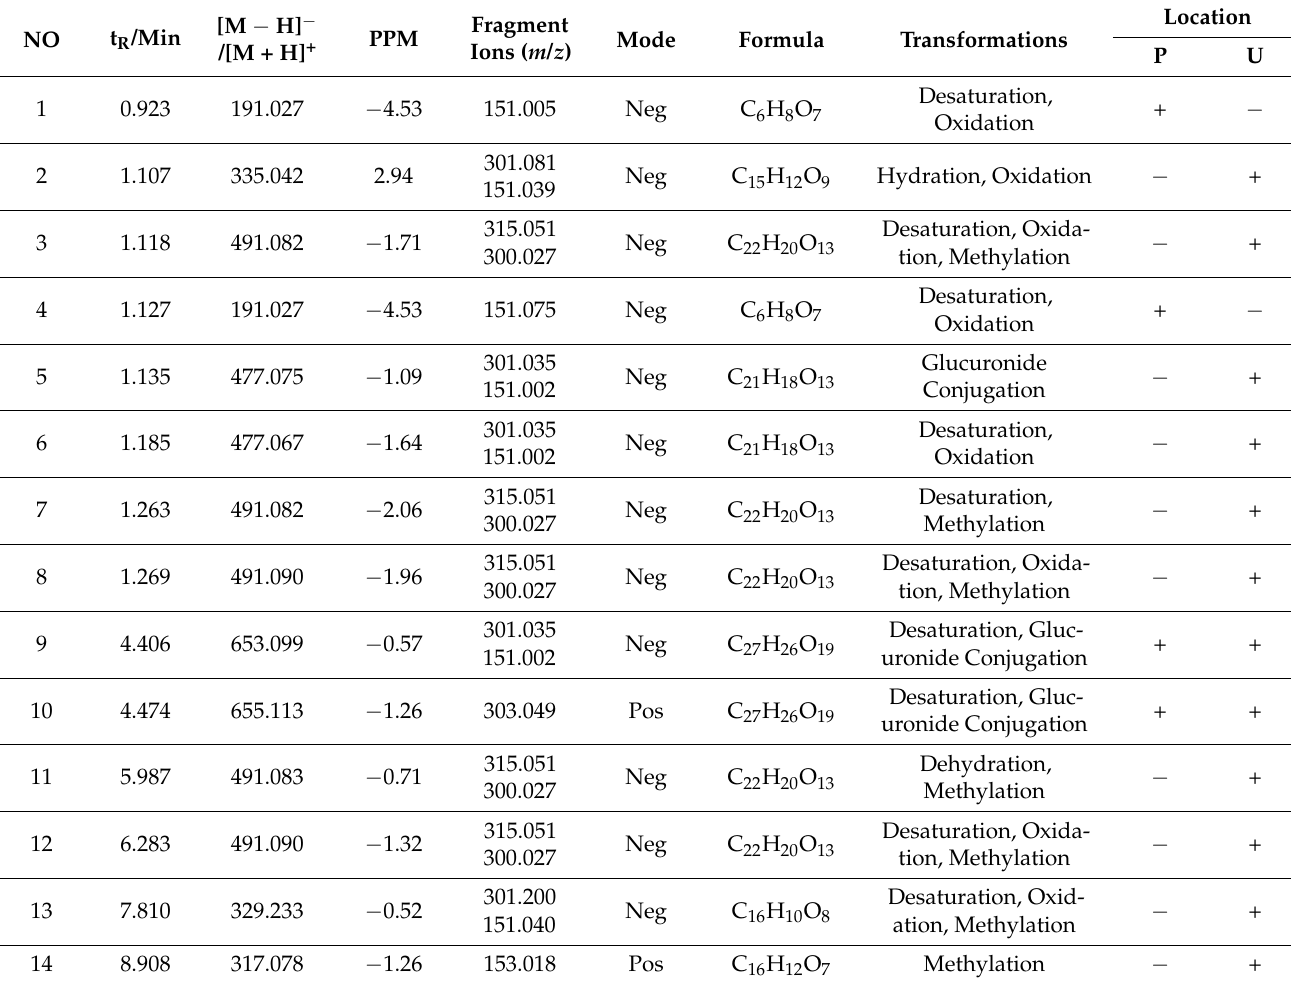
Table 3. Identification of metabolites of isoquercitrin in plasma and